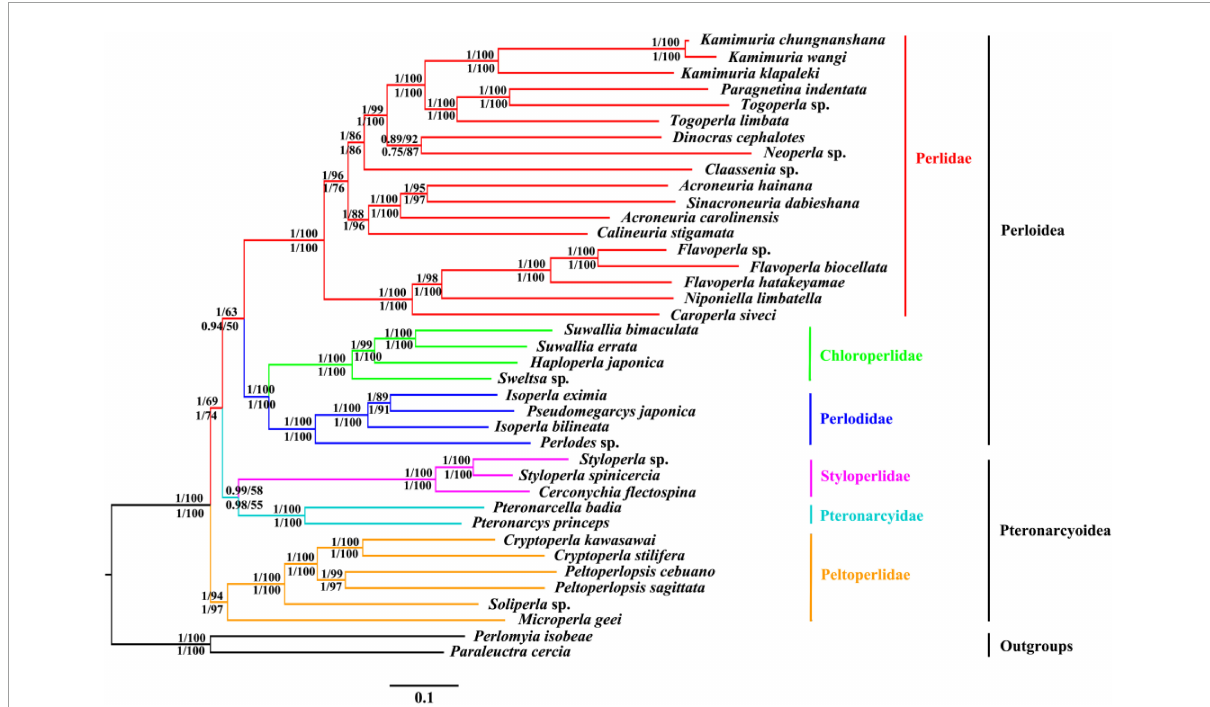
FIGURE7 Phylogenetic tree of the thirty-nine sequenced stoneflies. Bayesian inference and Maximum Likelihood analysis inferred from Protein-coding gene (PCG) and 13 PCGs and two rRNAs (PCGRNA) datasets supported the same topological structure. Values at nodes are ML bootstrap values and Bayesian posterior probabilities using the PCG (up) and PCGRNA (down) datasets. The tree was rooted with two outgroups ( Paraleuctra cercia and Perlomyia isobeae ).